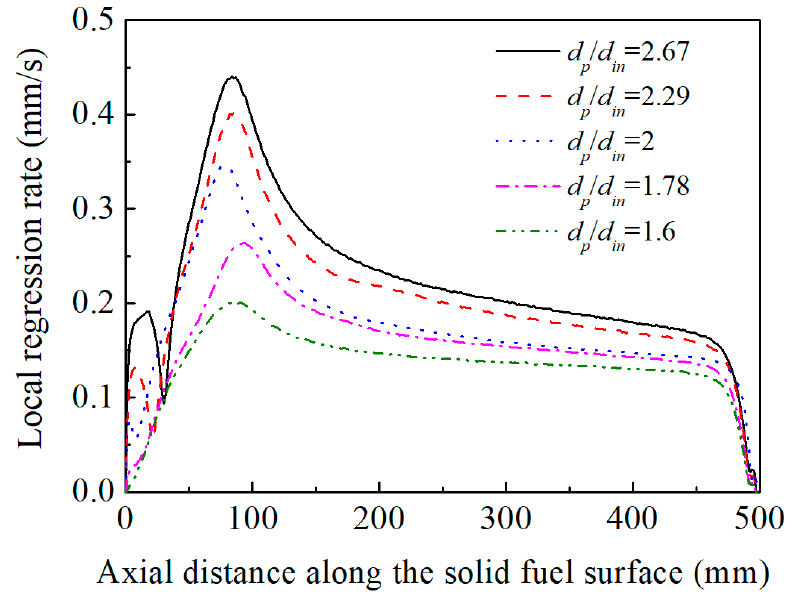
Figure 24. Local regression rate obtained from simulation for different cases.